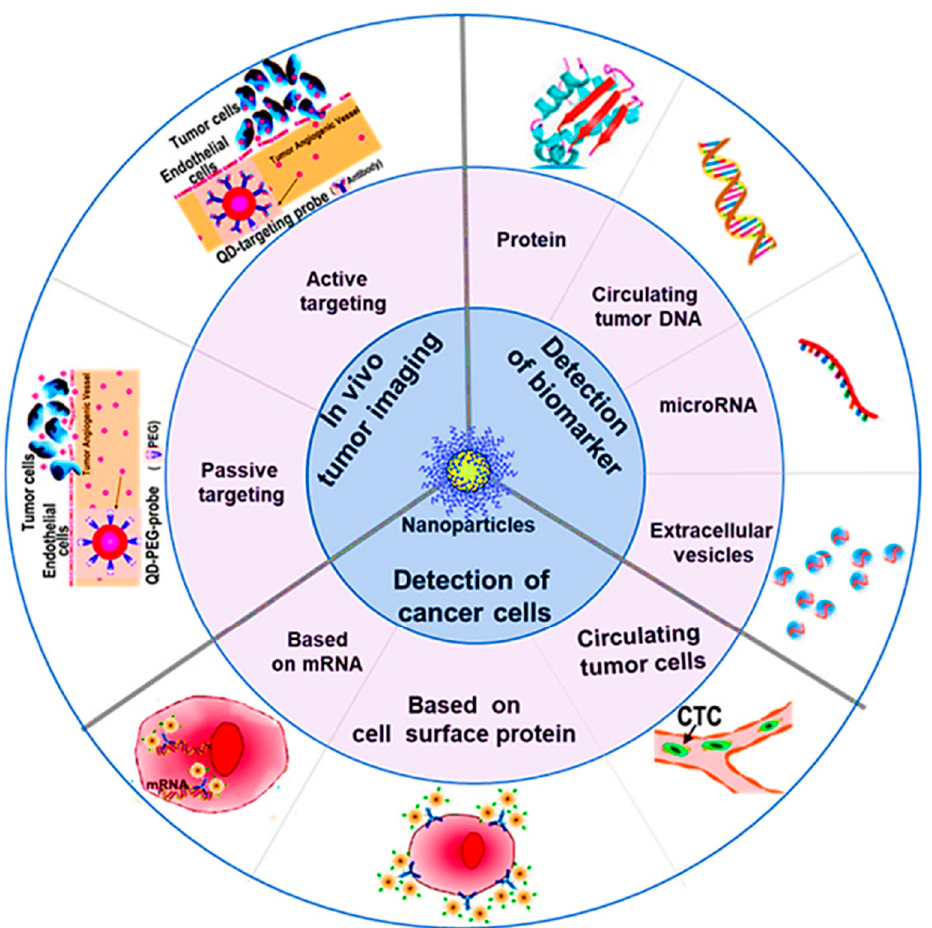
Figure 1. Mechanisms explored for the diagnosis of cancer using nanotechnology, reprinted from [86]. (Published under a Creative Commons Attribution 4.0 International license, https://crea- tivecommons.org/licences/by/4.0, accessed on 1 May